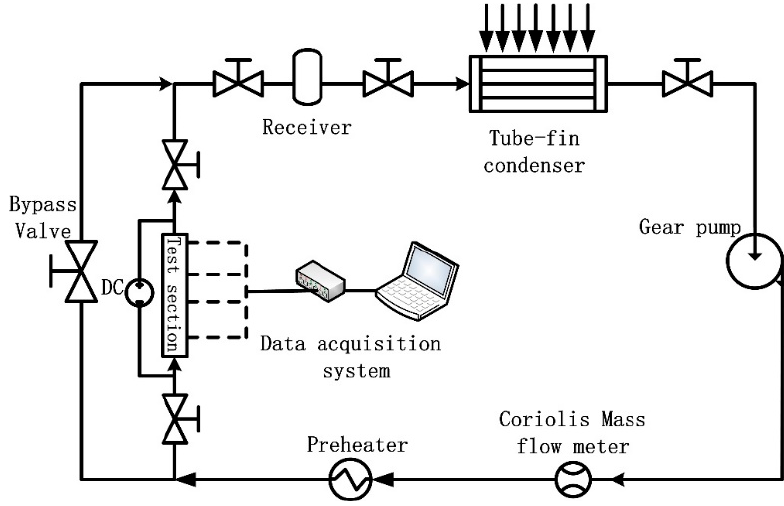
Figure 1. Schematic diagram of the experimental